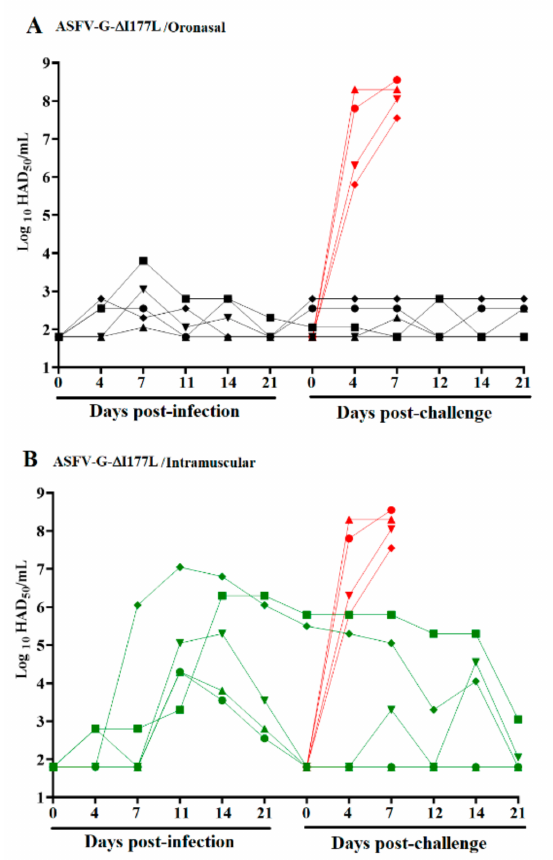
Figure 2. Viremia titers in pigs either oronasally or intramuscularly inoculated with ASFV-G- ∆ I177L before and after challenge with ASFV-G ( A , B ). Each curve represents individual data from each of the animals under each of the treatments. Red curves represent mock-inoculated animals used as controls during the challenge. The sensitivity of virus detection was ≥ 1.8 log 10 HAD 50